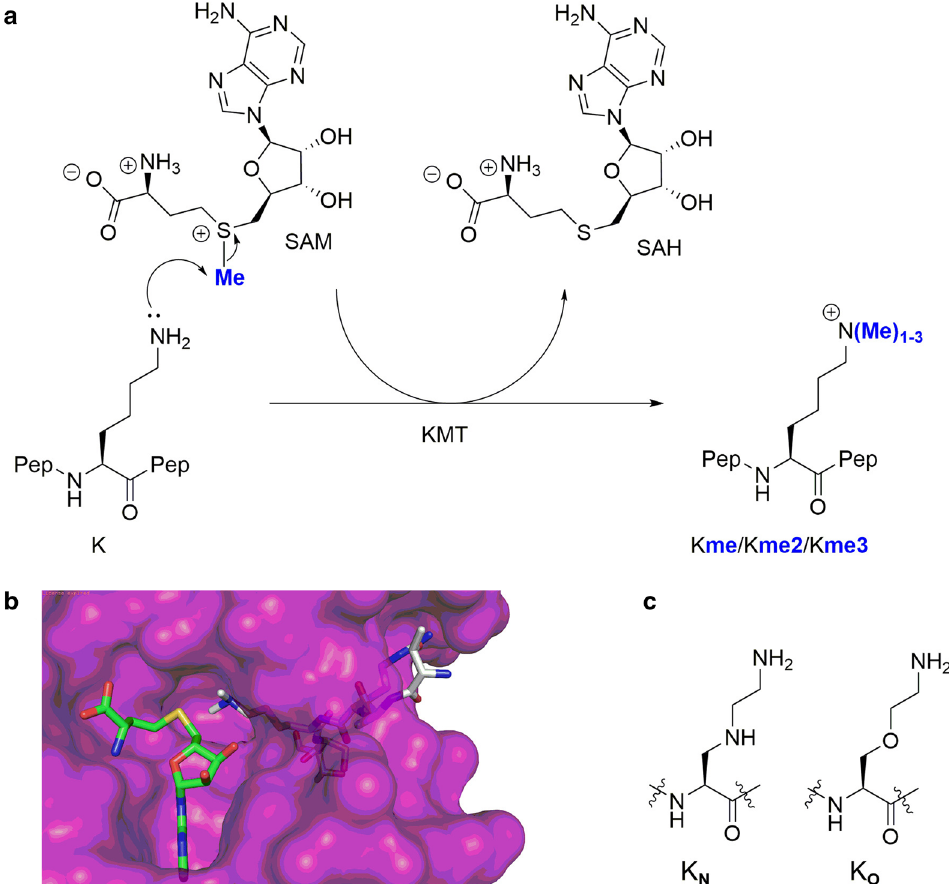
Figure 1. Histone lysine methylation. ( a ) Histone lysine methyltransferase (KMT)-catalyzed methylation of lysine in the presence of SAM cosubstrate. ( b ) View from a crystal structure of GLP complexed with the H3K9me2 histone peptide and SAH (PDB ID: 2RFI). ( c ) Lysine analogues K N and K O examined in the current